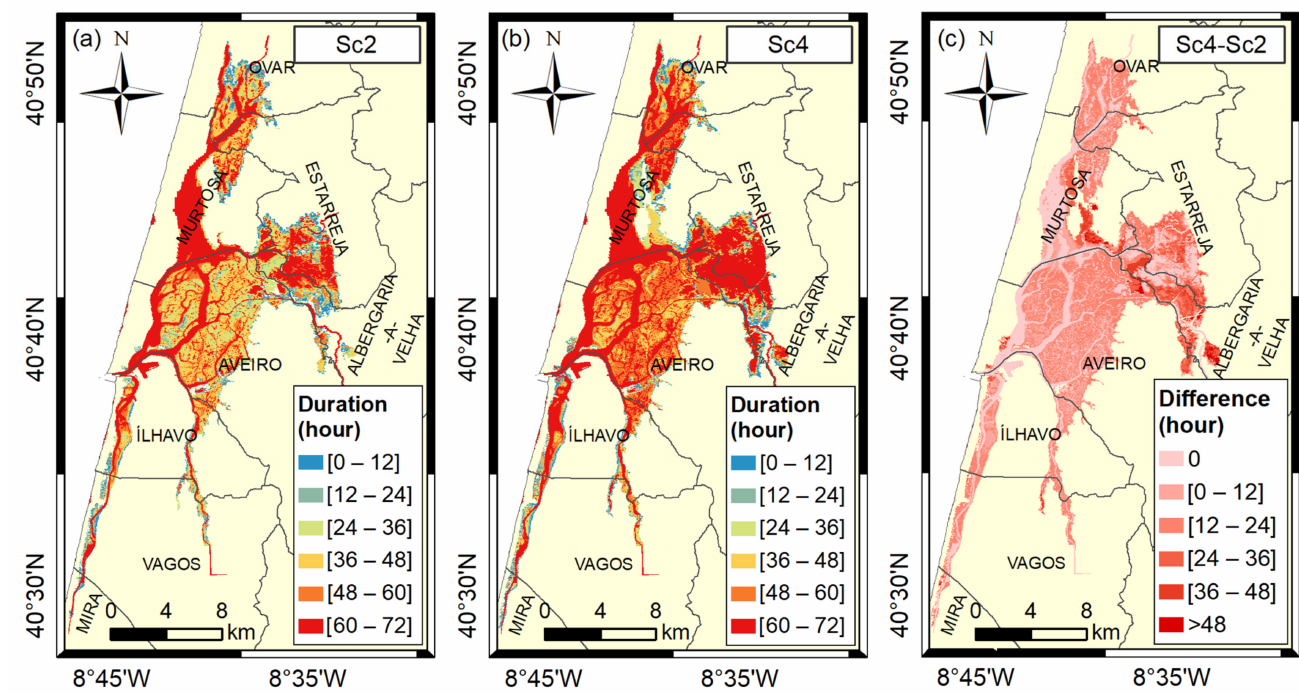
Figure 6. Duration of inundation caused by a 2-year return period storm surge under present MSL ( a ) and future MSL ( b ). The difference between the two scenarios ( c